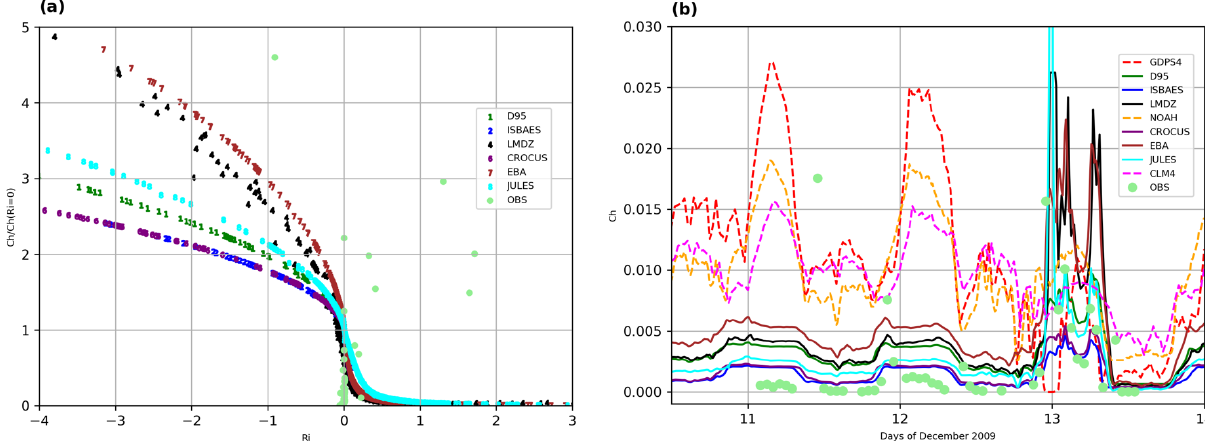
Figure 11. Turbulent exchange coefficient for heat C h normalized by its value under neutral conditions as a function of the Richardson number (a) , and C h as a function of time (b) .